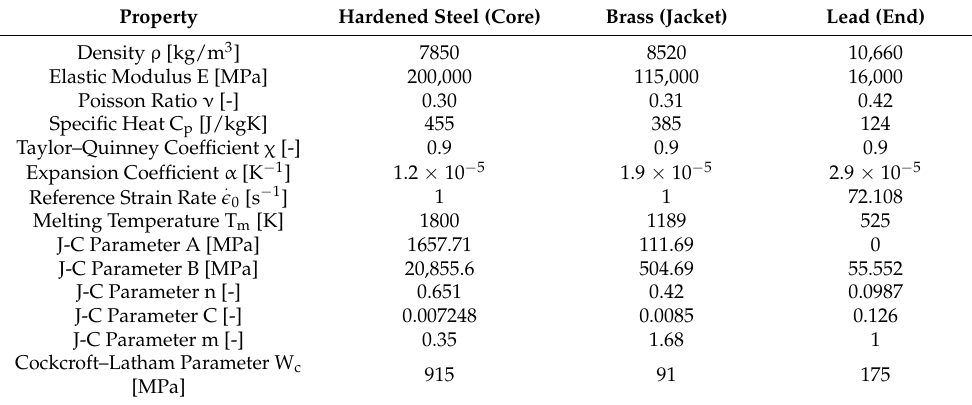
Table 4. Projectile materials input parameters [1,27,29,34,40].